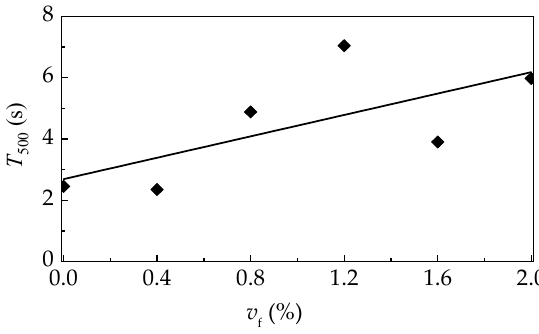
Figure 7. Slump flow time with a varying v f.